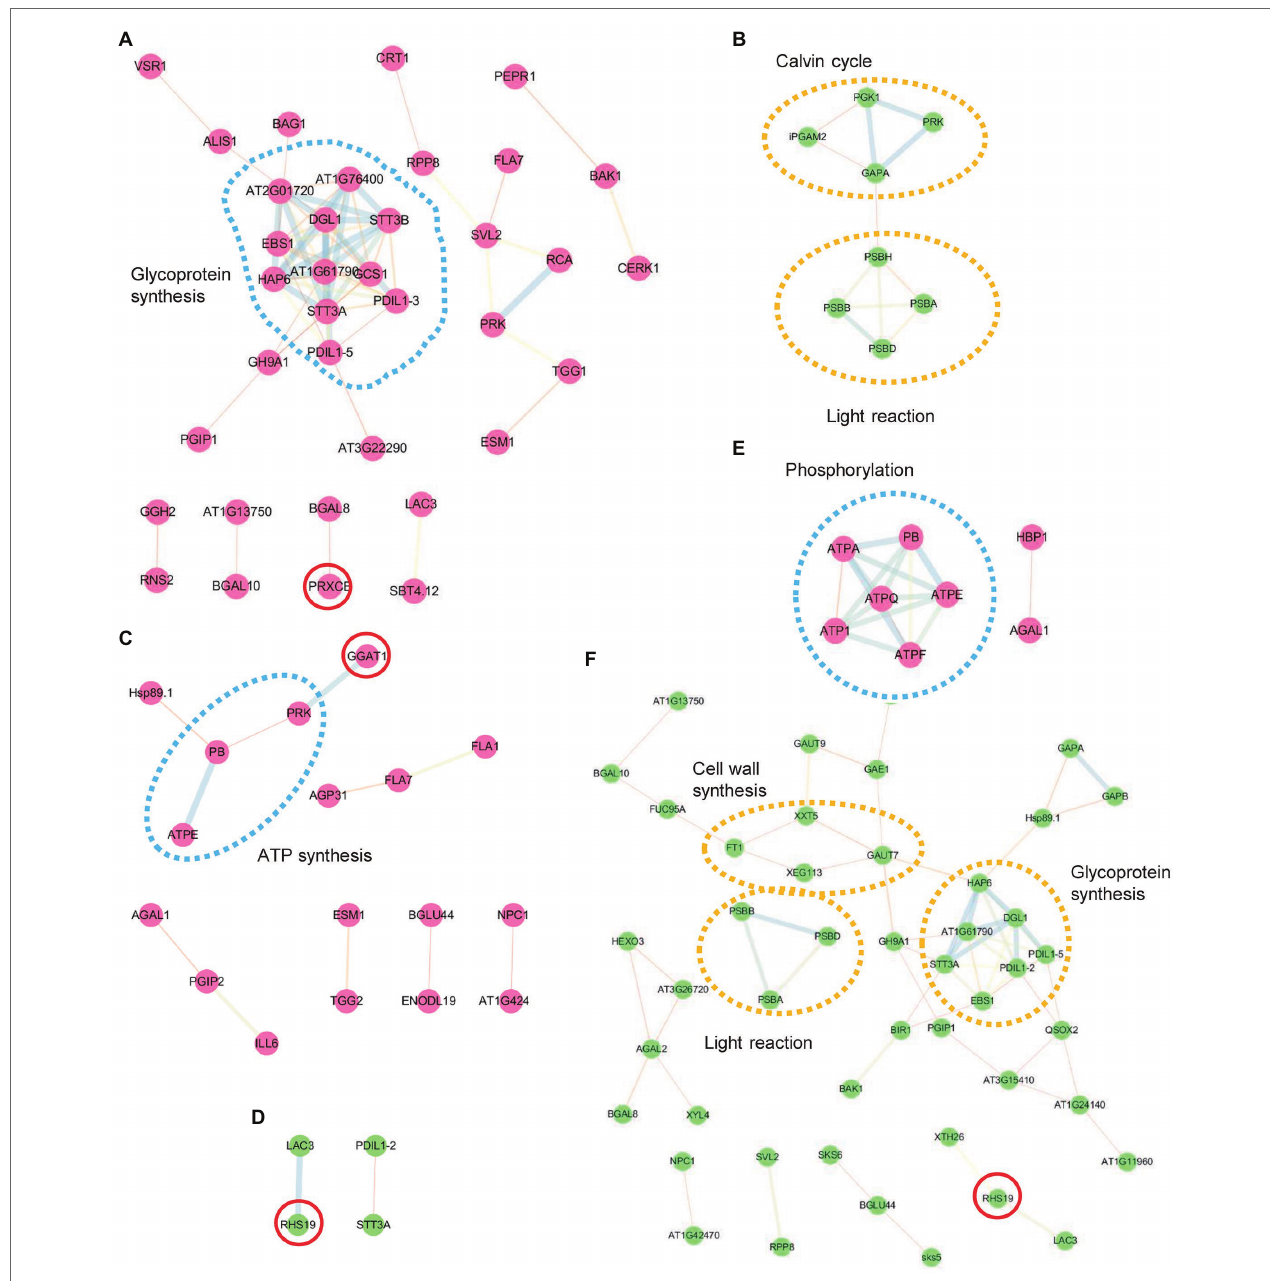
FIGURE 4 | Protein interaction network analysis using the STRING database. Interaction network of differentially abundant glycoproteins (DAGs) was performed with the STRING system (https://string-db.org) based on known and predicted interactions. Protein–protein interactions among increased (red points) and decreased (green points) proteins in the WT (A,B) , mns1 mns2 (C,D) , and cgl1-3 (E,F) were analyzed separately. Lines of different font-weight represent different types of evidence for the associations. The dotted circles highlight the involved biological processes. Red circles are proteins associated with the oxidation-reduction process. Proteins without interactions are not